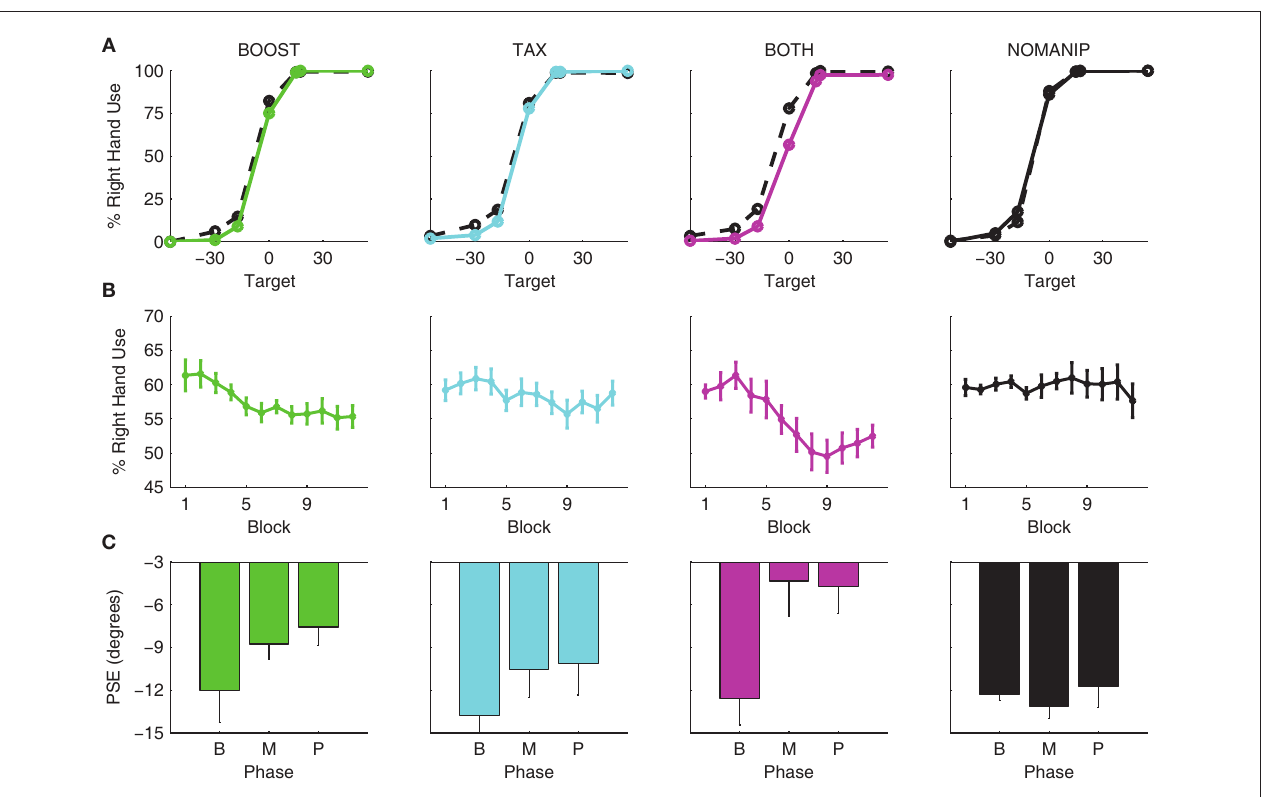
Figure 3 | Hand choice results for experiment 1 in the BOOST (green), TAX (cyan), BOTH (magenta), NOMANiP (black) conditions. (A) Mean probability of right hand use as a function of target location. Solid lines are for data from the last two blocks of the manipulation phase (Blocks 7–8) and dotted lines are for